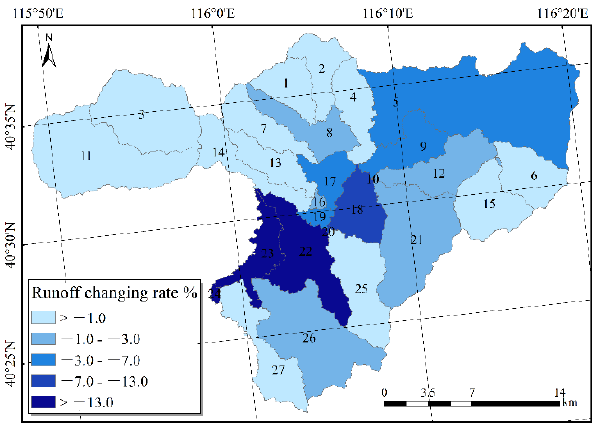
Figure 13. Contribution of land use change to runoff in each sub-basin.